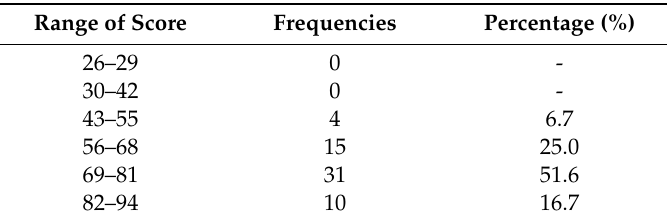
Table 4. Frequency of Distribution of DSES ( n = 60).